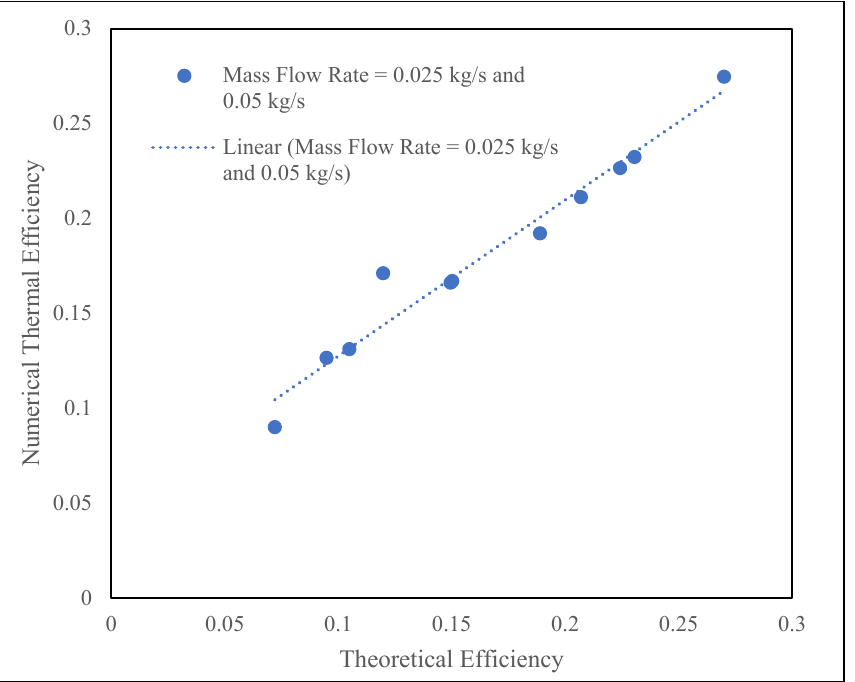
Figure 8. Theoretical versus numerical efficiency. Table 11. Different ambient conditions considered for validation.